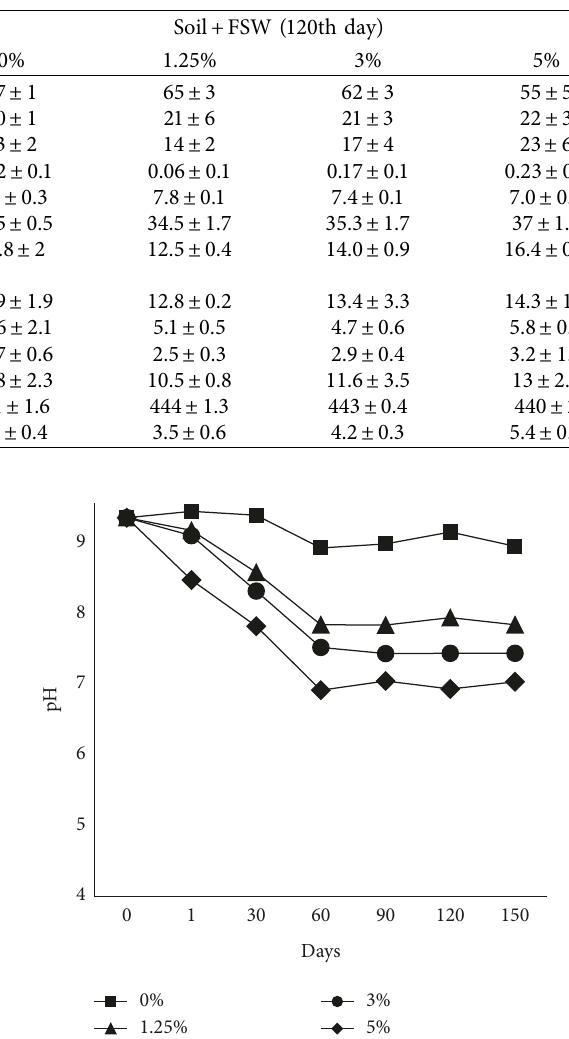
Figure 1: The impact of fermented seaweed (FSW) on the pH of the